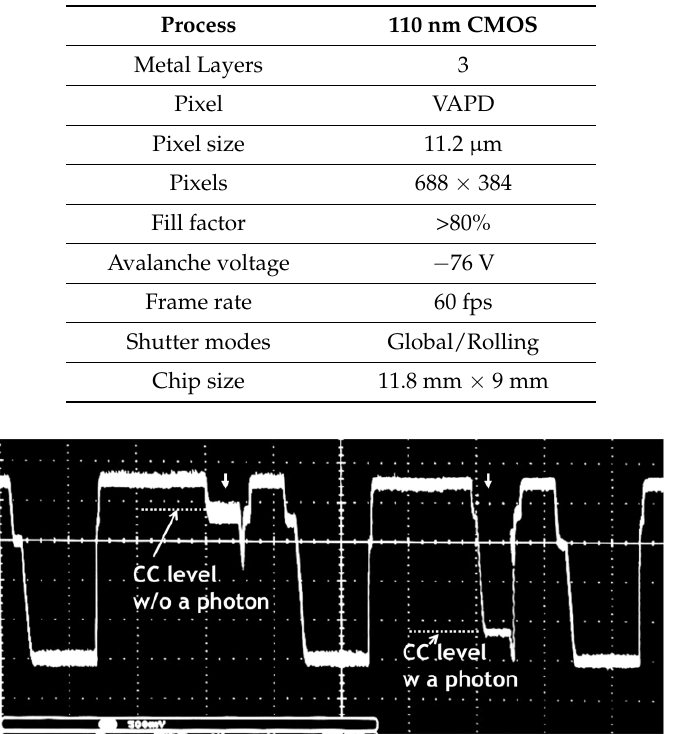
Table 2. Specification of a developed TOF-CIS.